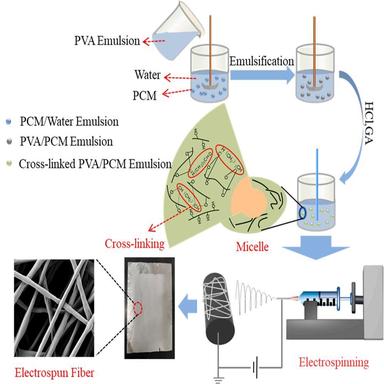
The schematic view of electrospinning setup.